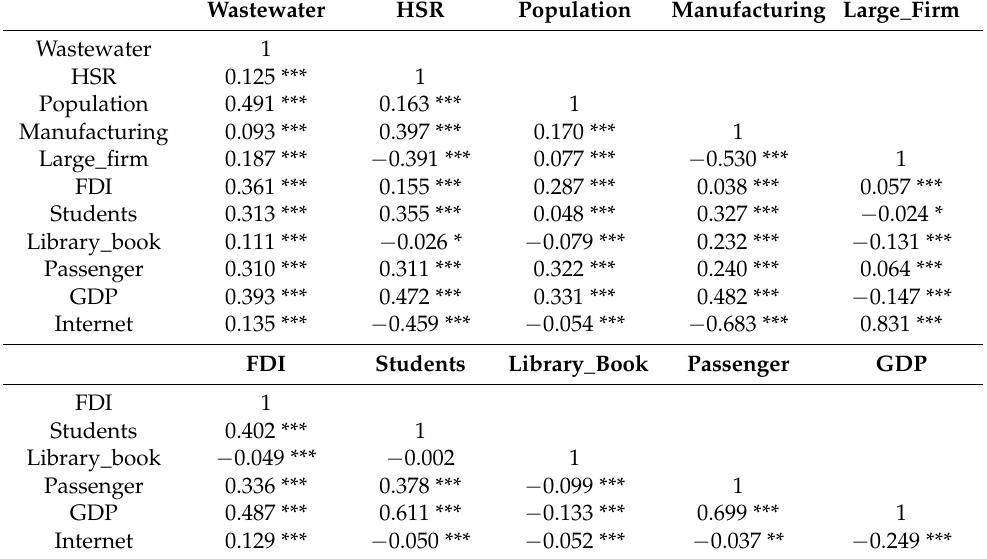
Table 2. Correlation test